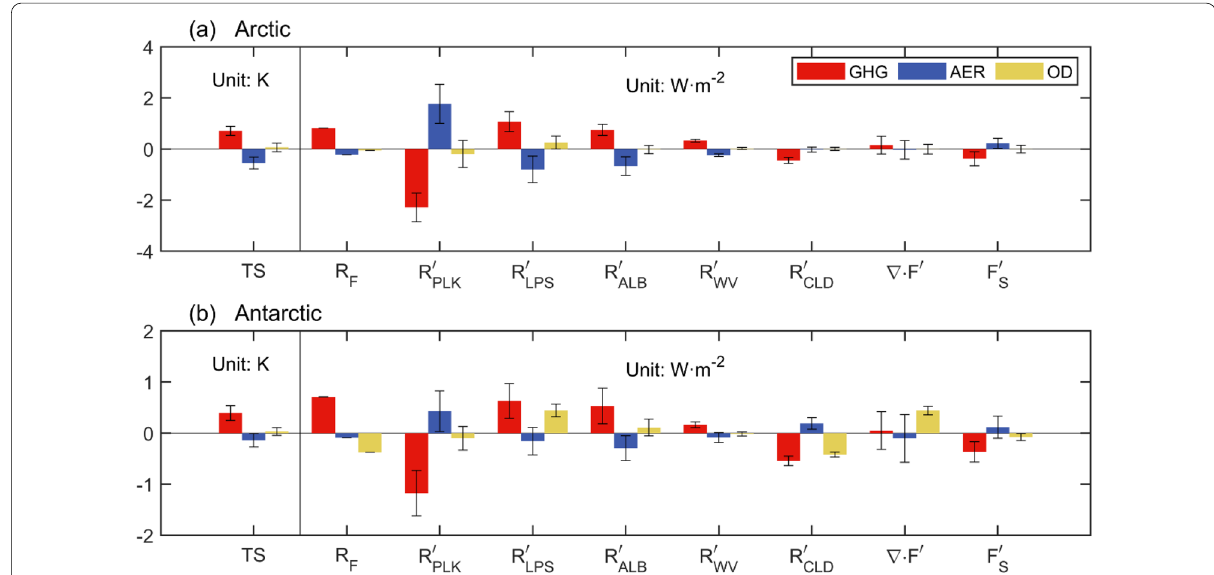
Fig. 3 Surface temperature changes ( K ) and contributions to the TOA heat flux ( W m − 2 ) from radiative forcing ( R F ), feedbacks of Planck (cid:31) R ′ PLK (cid:30) , lapse rate ( (cid:31) R ′ LPS (cid:30) , albedo (cid:31) R ′ ALB (cid:30) , water vapor (cid:31) R ′ WV (cid:30) and cloud (cid:31) R ′ CLD (cid:30) as well as atmospheric heat convergence ( ∇ · F ′ ) and surface heat flux ( F ′ s ) in GHG (red bars), AER (blue bars), and OD (yellow bars) over the a Arctic (60°–90° S) and b Antarctic (60°–90° N). The error bars denote the standard deviations of values in CESM-LENS members. Note the y-axis scales in a and b are